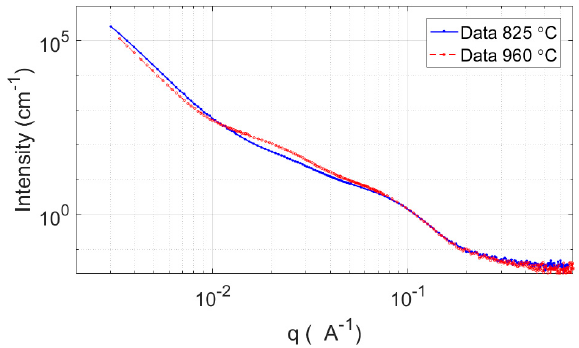
Figure 7. SANS data after ageing at 540 °C for 7.5 h for austenitisation conditions of 825 °C and 960